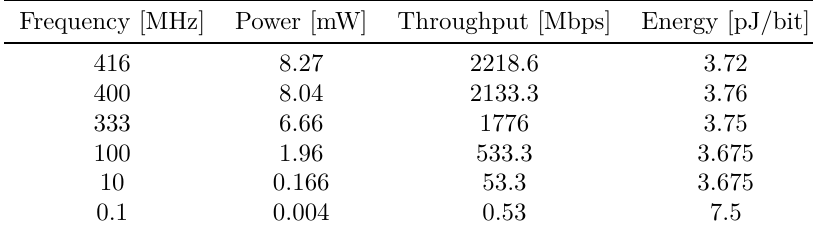
Table 12: Impact of clock frequency on the ASIC results with N u =